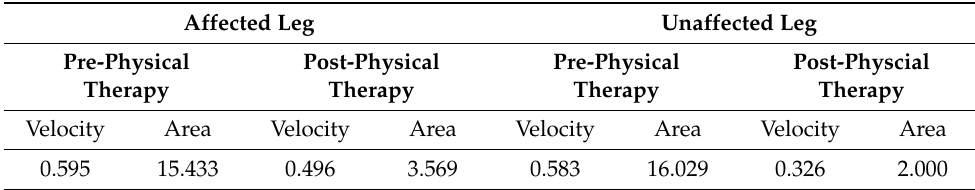
Table 3. Single-Leg Postural Steadiness.